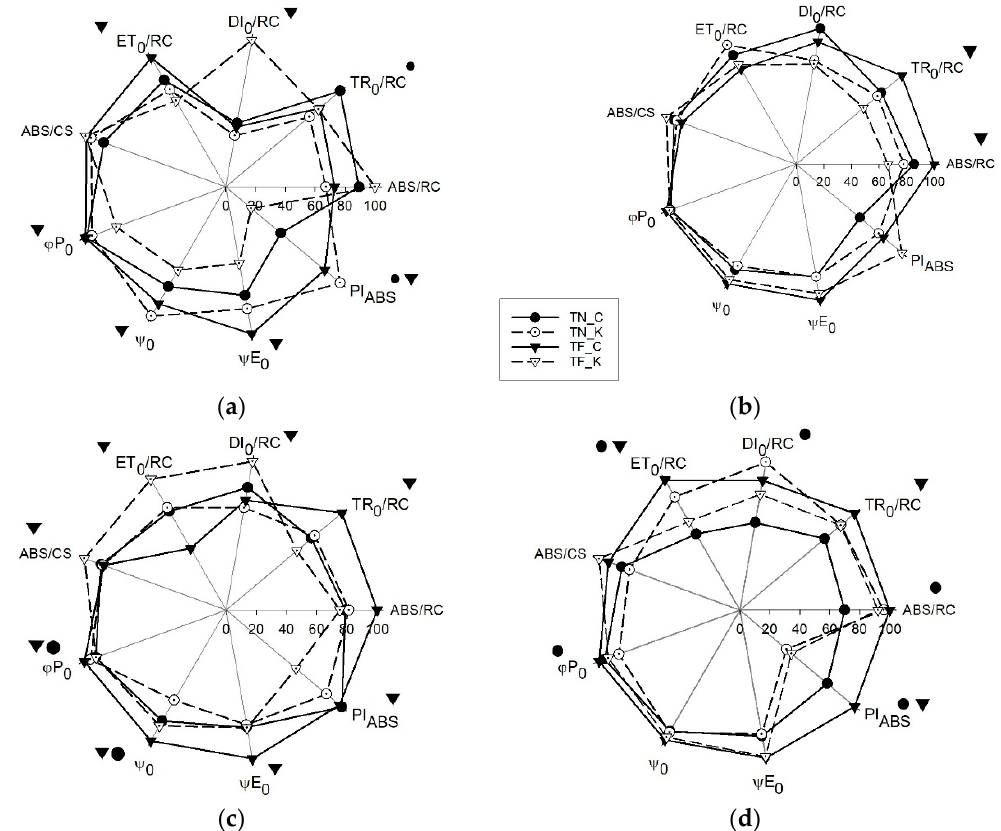
Figure 4. Radar plots of JIP parameters deduced from chlorophyll a fluorescence OJIP transients in the grapevine leaves of Touriga Nacional control (TN_C) and kaolin (TN_C), and Touriga Franca control (TF_C) and kaolin (TF_K) in the Alentejo site at stages EL35 and EL38 of 2017 ( a , b ) and 2018 ( c , d ). Data are mean ± SD ( n = 18). For each parameter, the lower value represents relative change against the maximum value, set as 100%. Closed circles ( ⬤ ) and triangles ( ⯆ ) at the top of each parameter represent significant differences between treatments in Touriga Nacional and Touriga Franca, respectively.